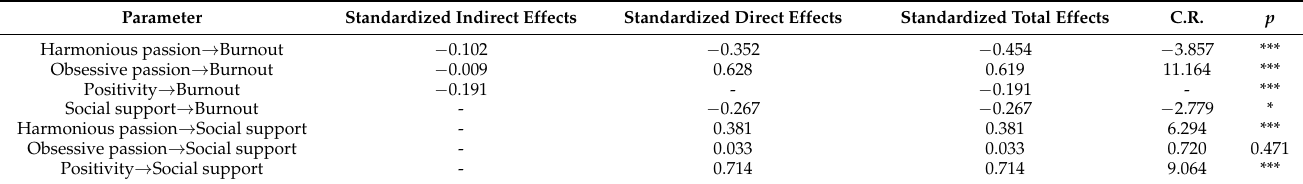
Table 3. Path analysis for the research model, critical ratios, standardized indirect, direct and total effects.